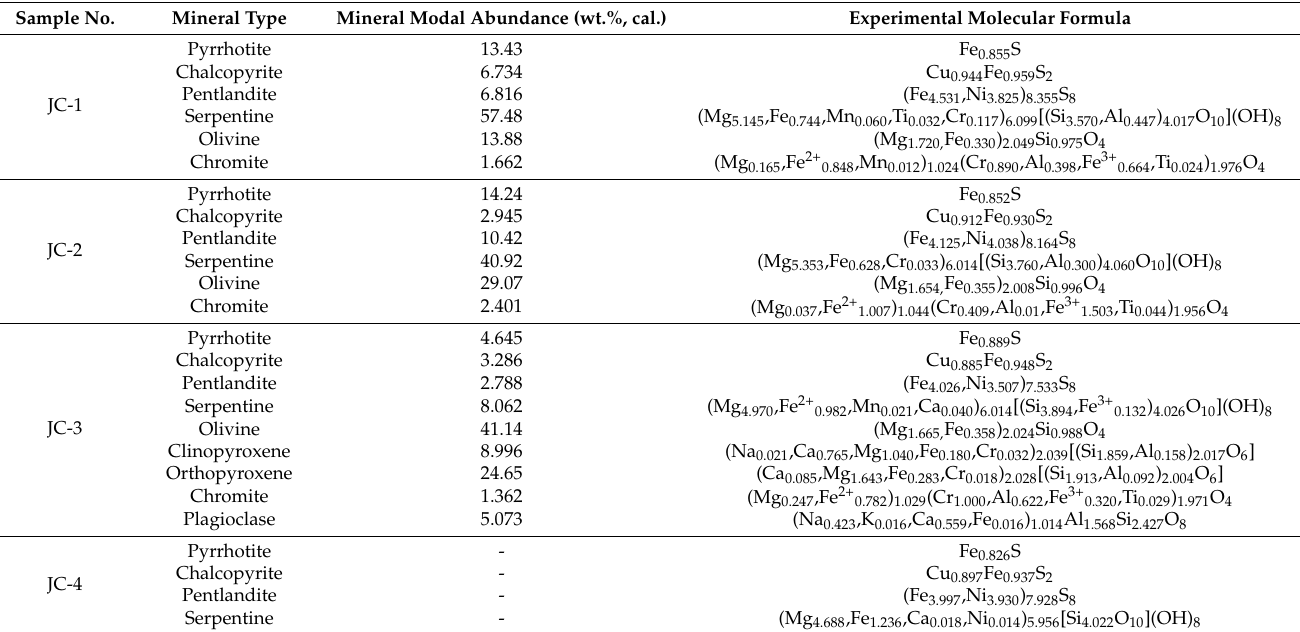
Table 8. Calculated content of each mineral in net-textured ore samples and experimental molecular formula of each